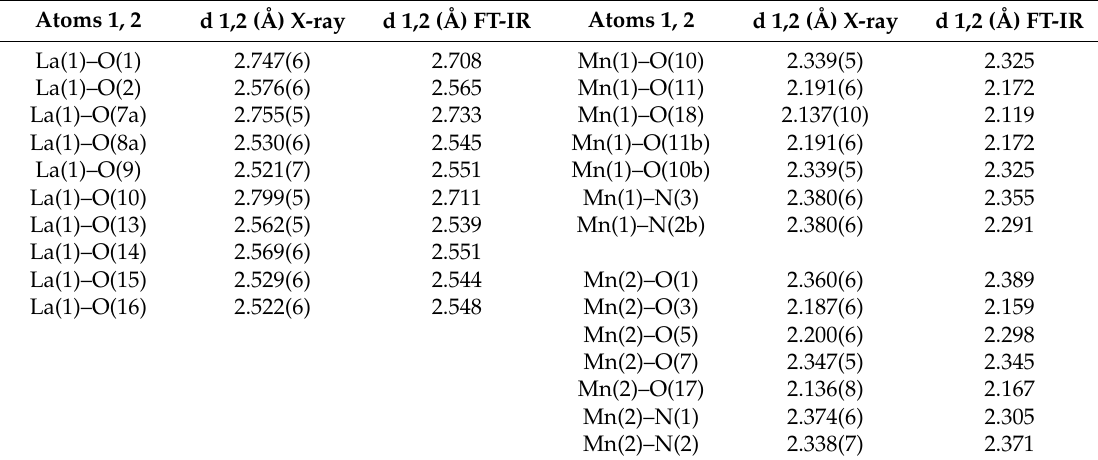
Table 2. Selected bond lengths (Å) and angles ( ◦ ) for Compound